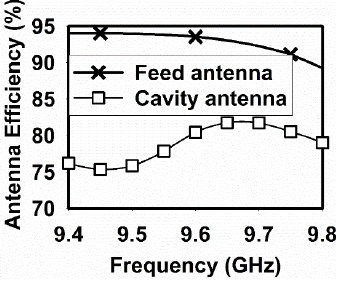
Figure.10. Measured Efficiency